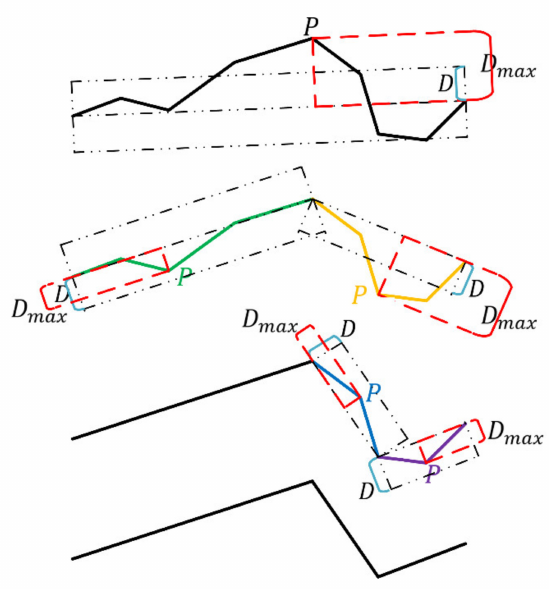
Figure 2. Principle diagram of DP